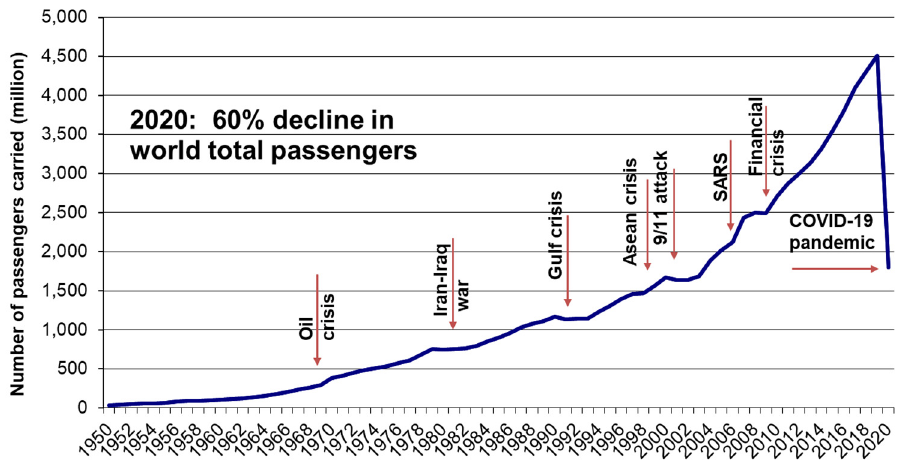
Figure 5. Development of global air traffic since 1950 [41], [own illustration].